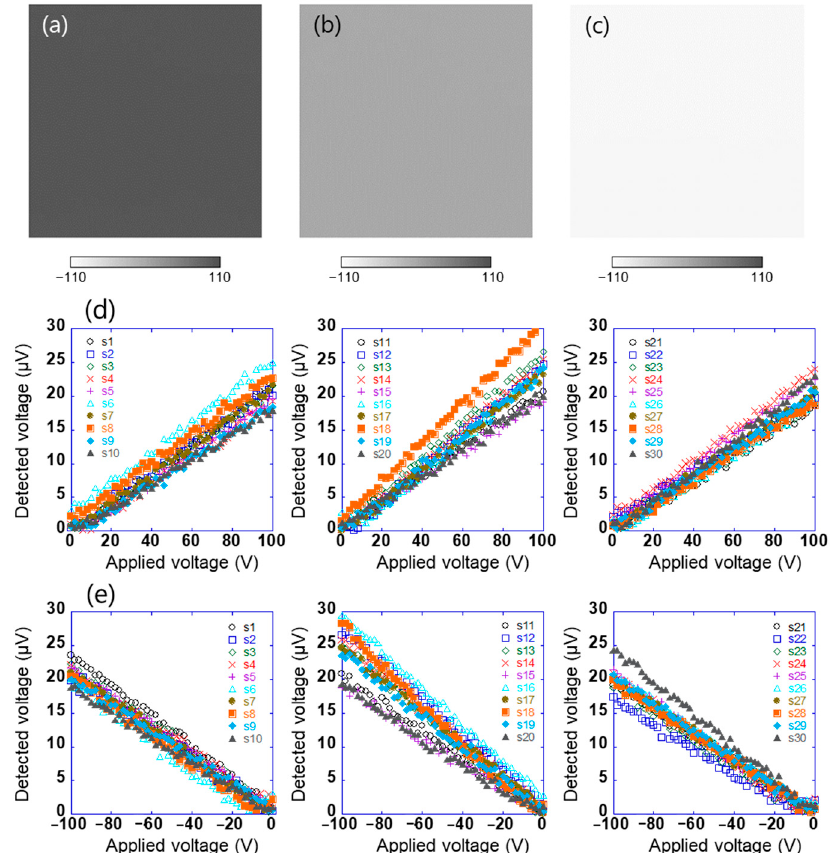
Figure 3. Surface potential distribution of test sample 1 which was applied ( a ) 100 V, ( b ) 0 V, and ( c ) − 100 V, and the relationship between applied voltages of test sample 1 in the range of ( d ) 0 to +100 V and ( e ) − 100 to 0 V and voltage detected using each sensor (s 1 –s 30 ).